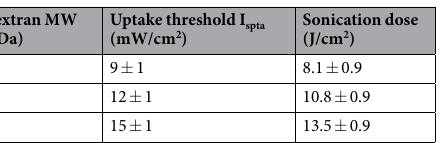
Table 1. Threshold I spta values for the activation of the SP process for different MWs of the internalized dextrans, and their correspondent sonication